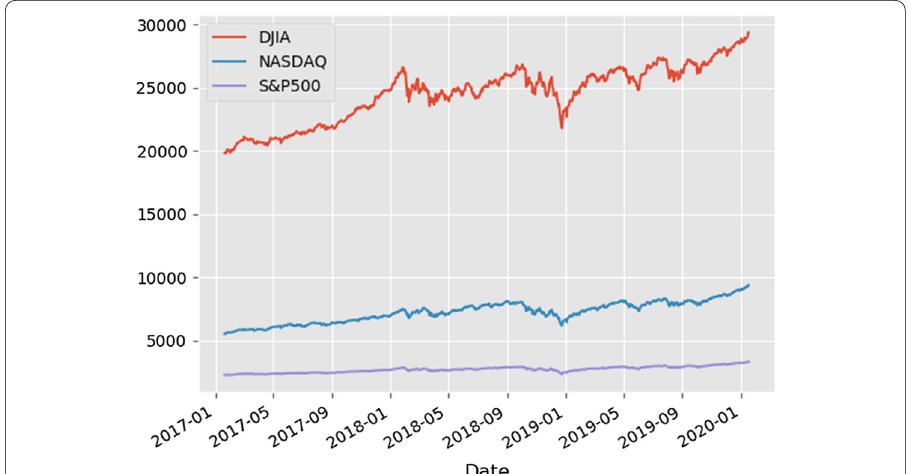
Fig. 6 Representation of the closing price of the three stock market indices, the Dow Jones Industrial Average (DJIA), NASDAQ and S&P 500, during the period between January 20, 2017 and January 20,